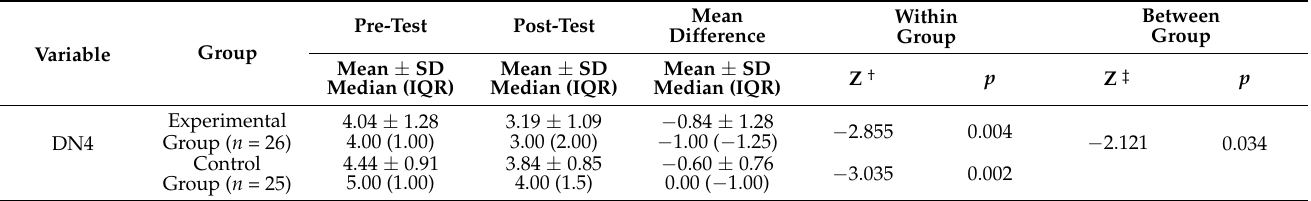
Table 4. Comparison of neuropathy-related dependent variables between groups ( n = 51).